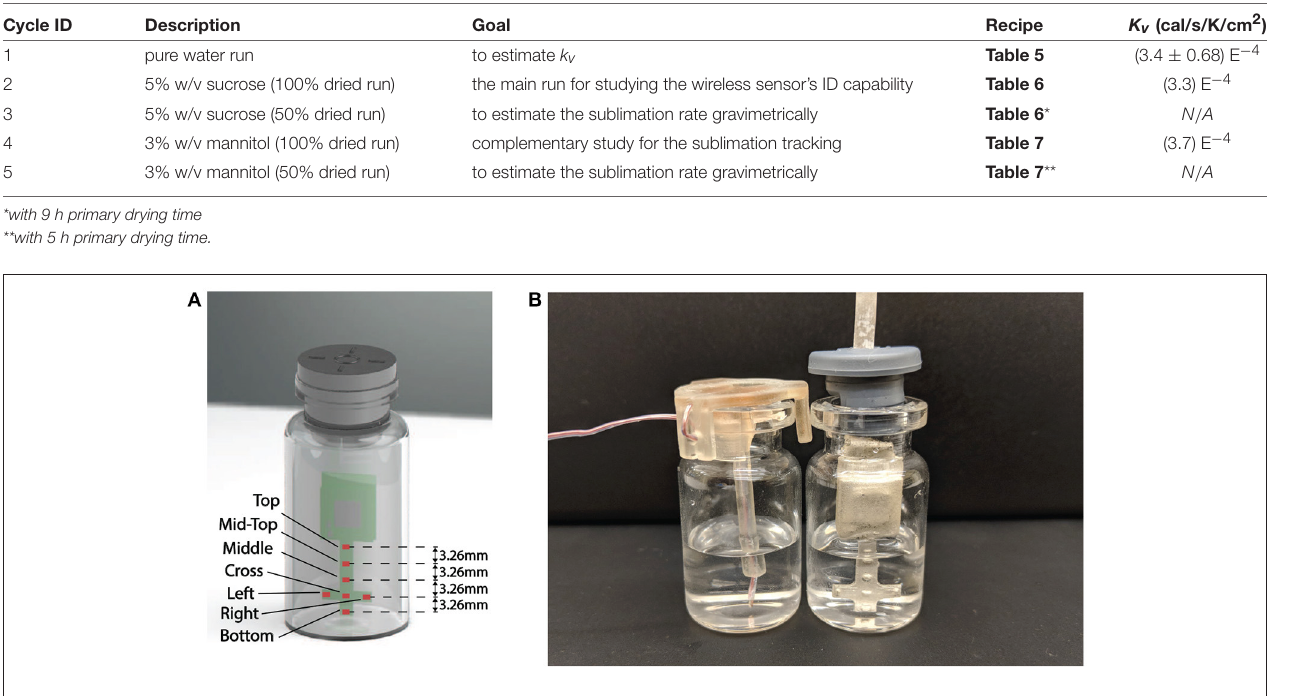
FIGURE 4 | (A) Representation of the wireless multi-point sensor. Seven sensing elements are labeled. (B) Placement of Wireless multi-point sensor and thermocouple in the